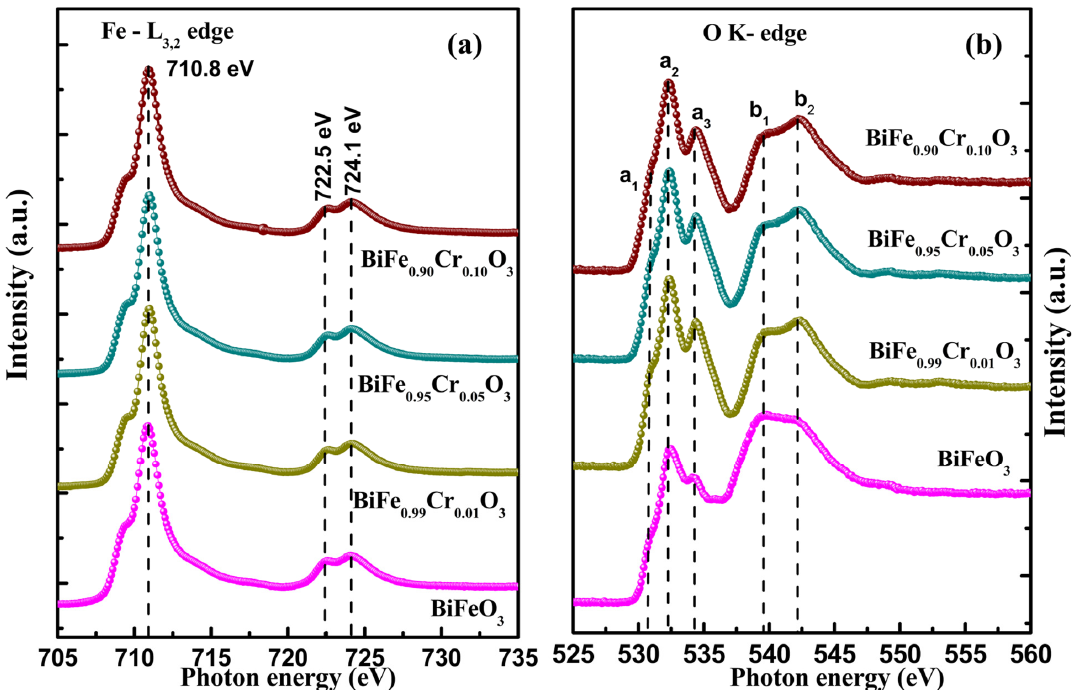
Figure 9. ( a ) Fe L 3,2 edge and ( b ) O K edge spectra of BiFe 1 − x Cr x O 3 (0 ≤ x ≤ 10)